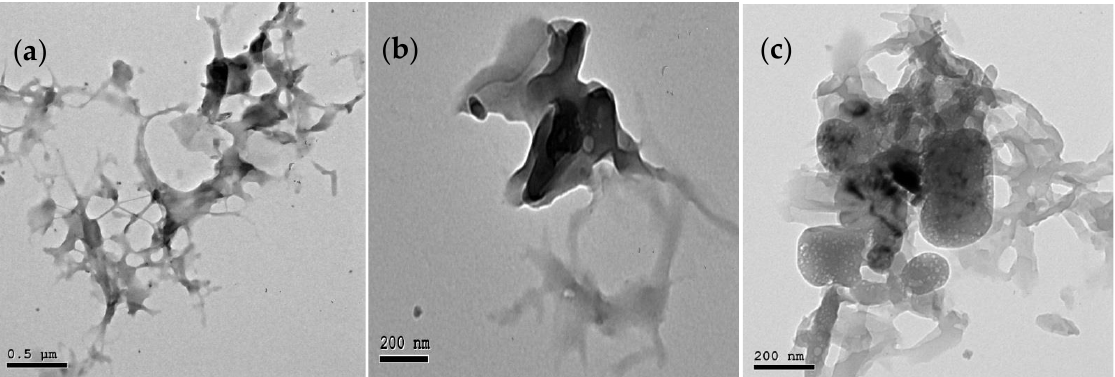
Figure 2. XRD pattern of WTP and PANI@WTP nanocomposite.